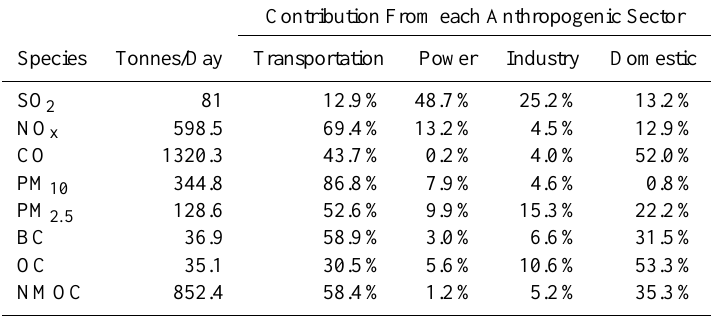
Table 2. Anthropogenic emissions and % sectoral contribution for